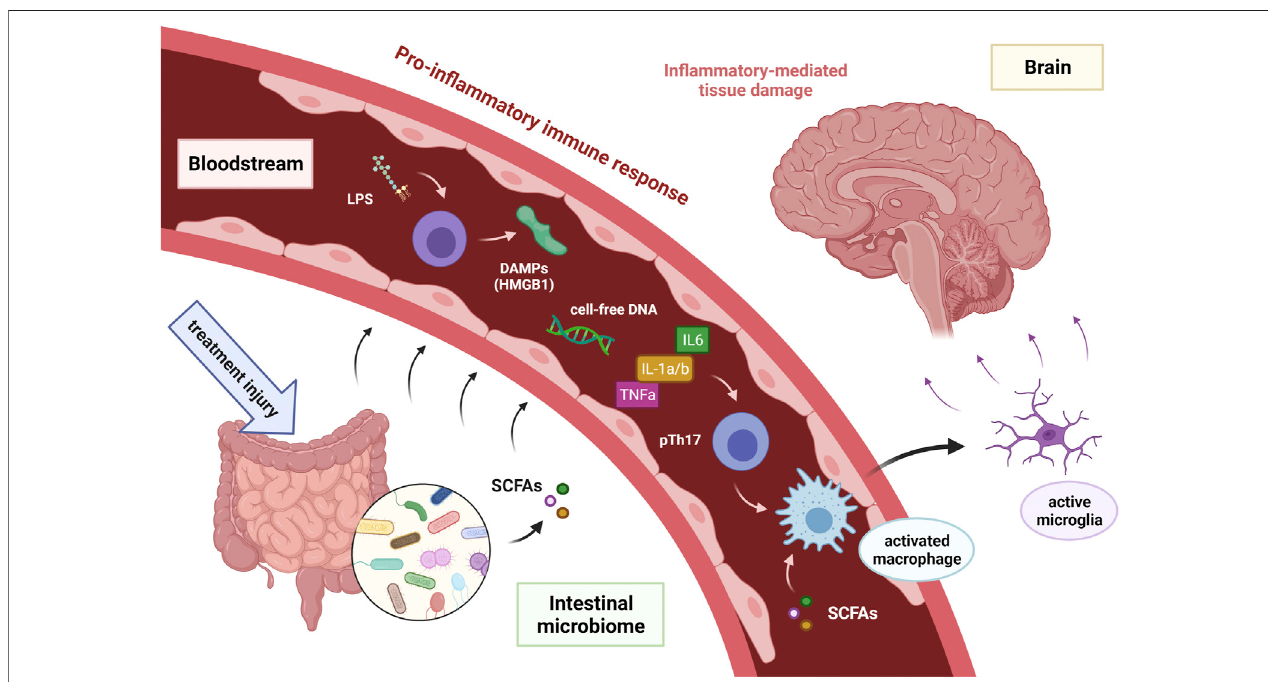
FIGURE 2 | Hypothetical model of proposed immune-related mechanism of cancer treatment induced cognitive impairment in cancer survivors [adopted from Ciernikova et al. (2021)]. Abbreviations DAMPs (cid:1) damage-associated molecular patterns; HMGB 1 (cid:1) high-mobility group box 1; IL-1a/b (cid:1) interleukin 1a and 1b; IL6 (cid:1) interleukin 6; LPS (cid:1) intestinal microbiota associated lipopolysaccharide; SCFAs (cid:1) short-chain fatty acids produced by intestinal microbiota; TNFa (cid:1) tumor necrosis factor-alpha.